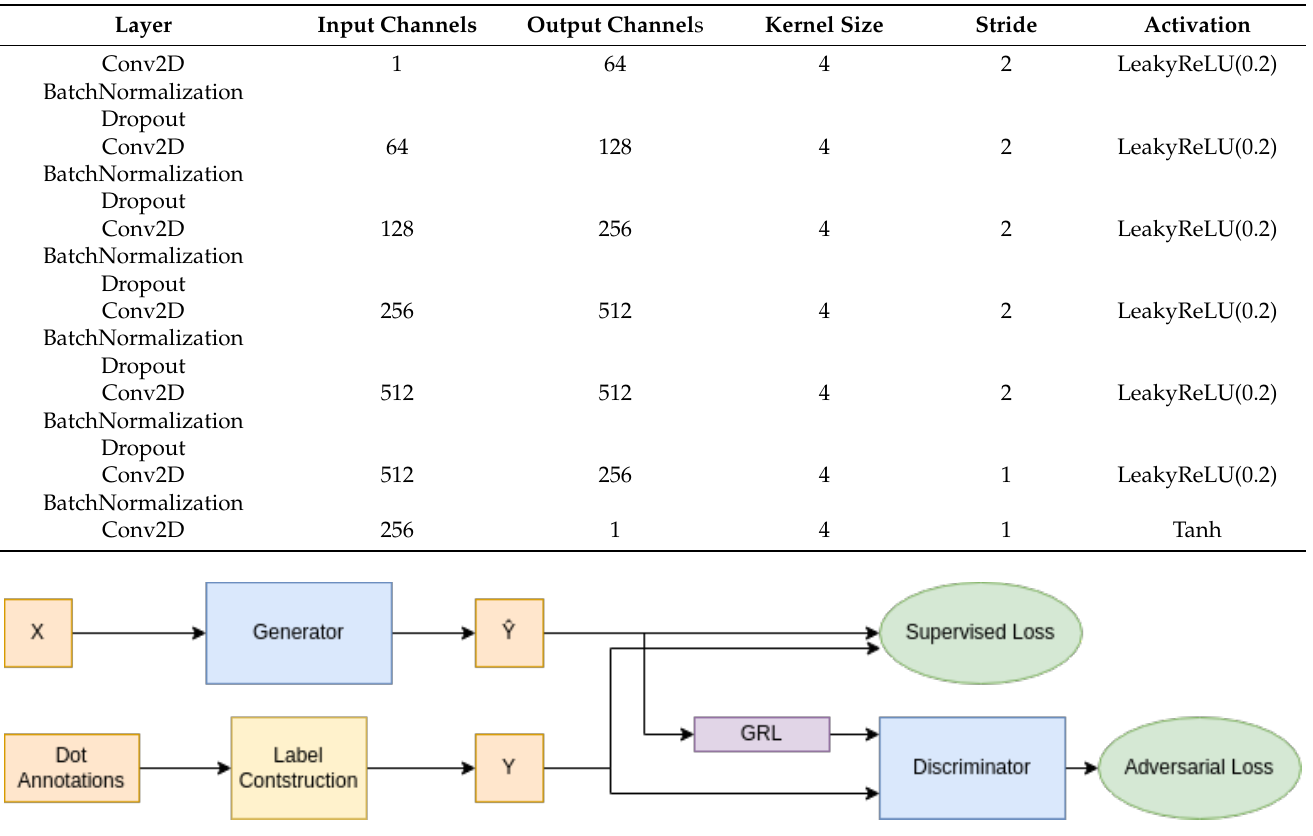
Figure 3. The baseline method uses two neural networks, G and D image , which are trained together in an adversarial manner. G attempts to map input images to center maps, while D image tries to distinguish between ground truth and generated outputs. The gradient reversal layer (GRL) allows both networks to be trained together, even though they have opposing objectives, by reversing the sign of the gradient and scaling it when it flows from D image to G . This allows the networks to be trained in a single